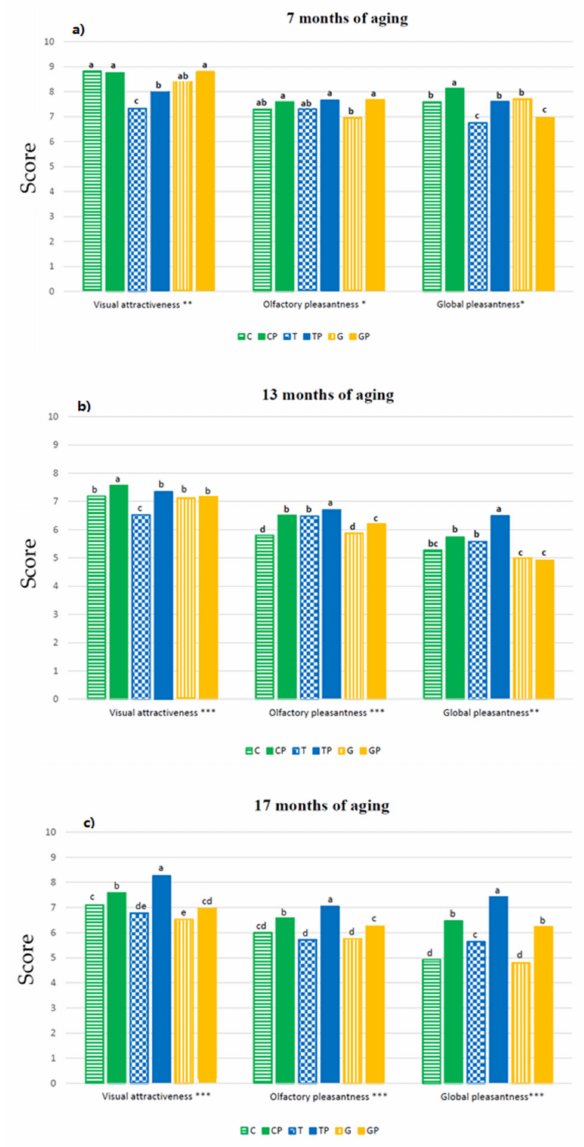
Figure 8. Hedonic parameters of wines after: ( a ) 7 months of aging (May 2020), ( b ) 13 months of aging (November 2020), and ( c ) 17 months of aging (March 2021). The evaluation was carried out using a score (0–10). Different letters indicate statistically significant differences at p ≤ 0.05 according to the results of two-way ANOVA. Significance level *** p < 0.001, ** p < 0.01; * p ≤ 0.05; ns: not significant ( p >